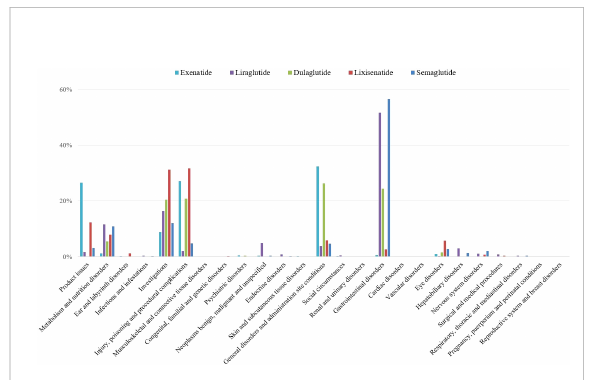
FIGURE 2 Proportion of positive signal for different GLP-1 RAs in system organ